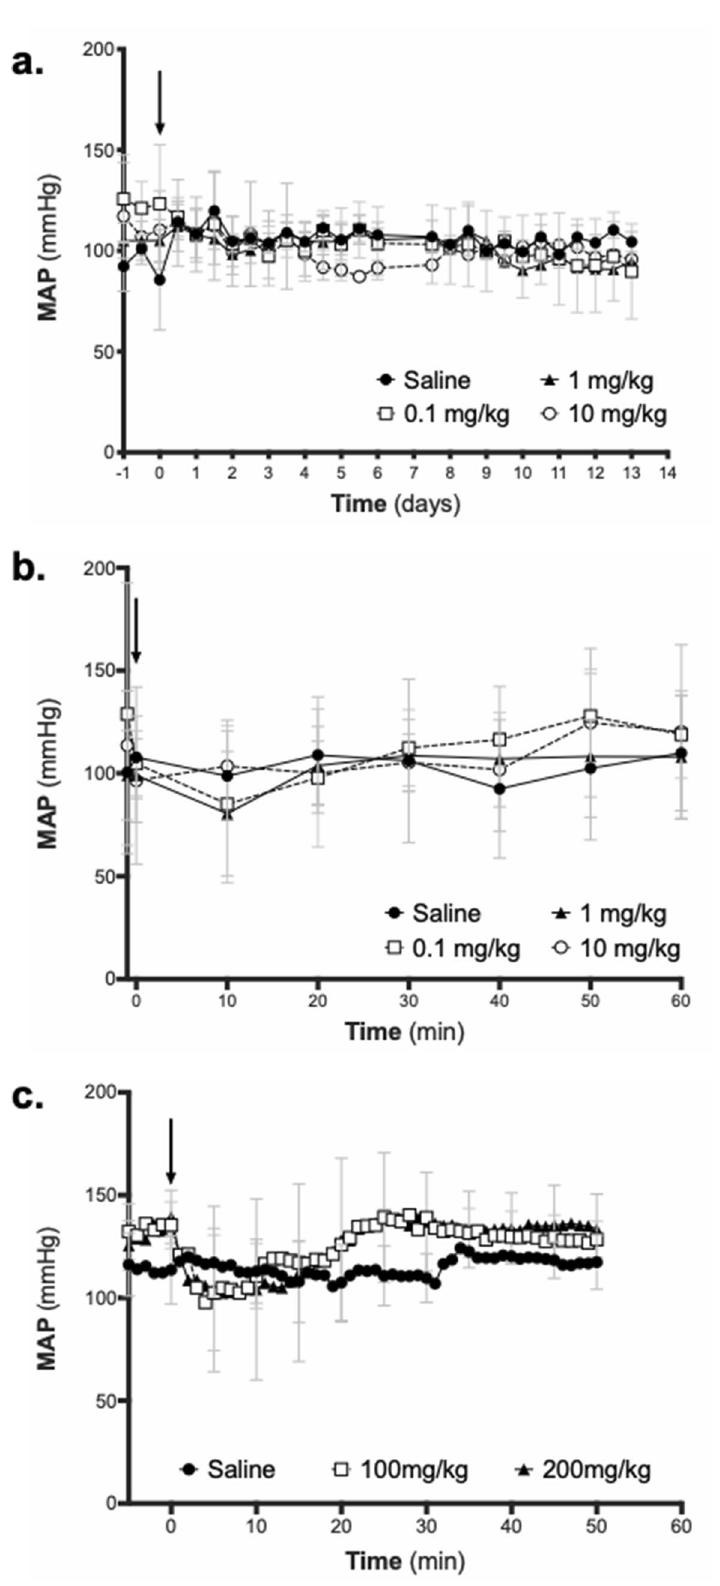
Figure 1. Effect of ELP-VEGF on mean arterial pressure (MAP). Increasing IV bolus doses of ELP-VEGF beginning at the therapeutic doses of 0.1 and 1.0 mg/kg and increasing to the supra-therapeutic dose of 10.0 mg/kg were administered to rats, and MAP was continuously monitored by carotid telemetry for 14 days (a) . Acute effects during the first 60 min after injection are shown in (b) . Ultra-high doses (100 and 200 mg/kg) were also tested for acute effects on MAP via conscious carotid catheter-based blood pressure monitoring (c) . ( ↓ indicates time of